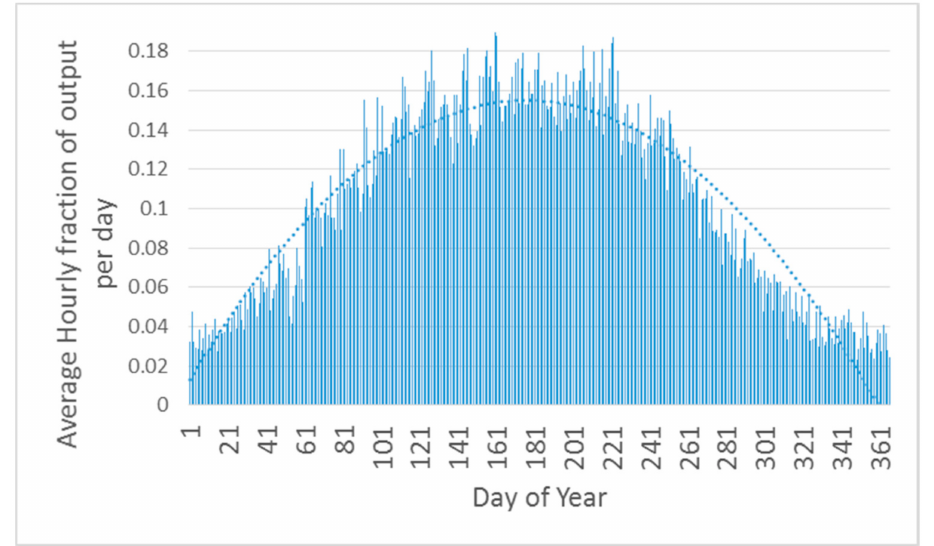
Figure 15. Average hourly fraction of output on a daily basis (2005–2014).